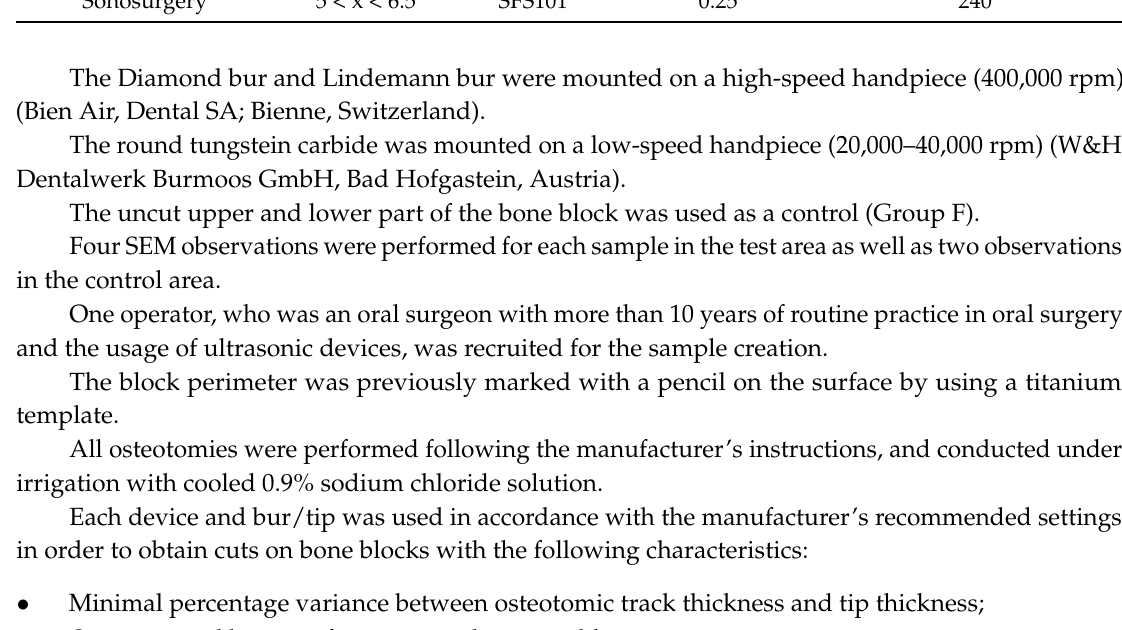
Table 2. Features of tips as reported by manufacturers.